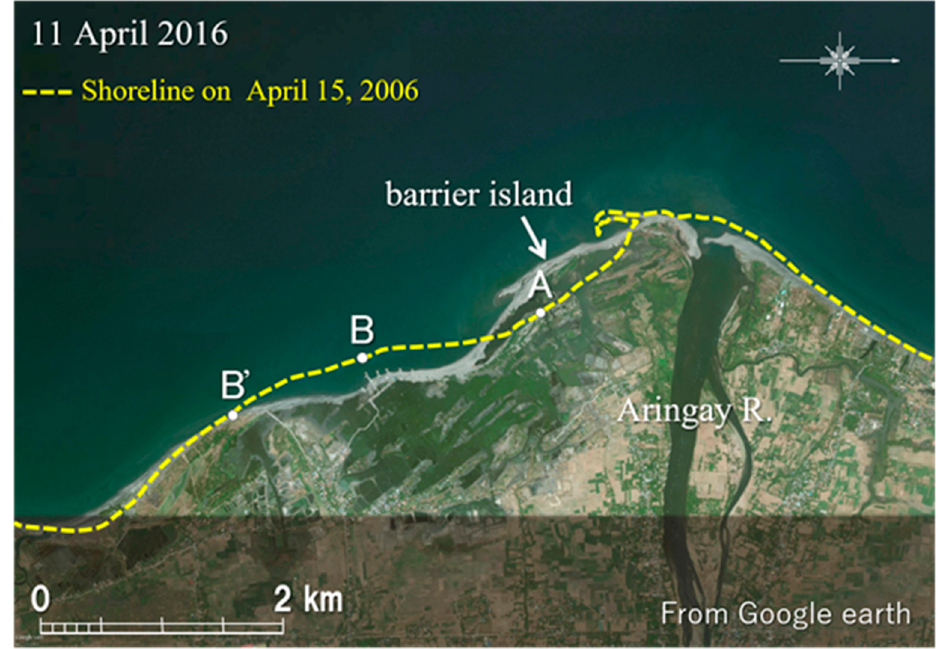
Figure 16. Satellite image of shoreline around Aringay River mouth (11 April 2016).